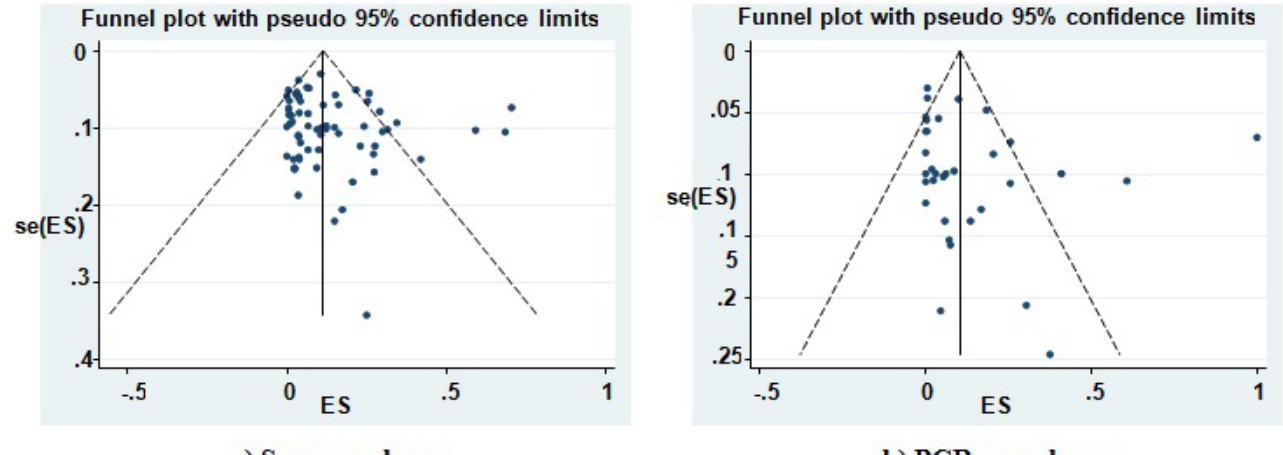
Figure 3. Funnel plot for seroprevalence ( a ) and PCR prevalence ( b ) of Leishmania infection in